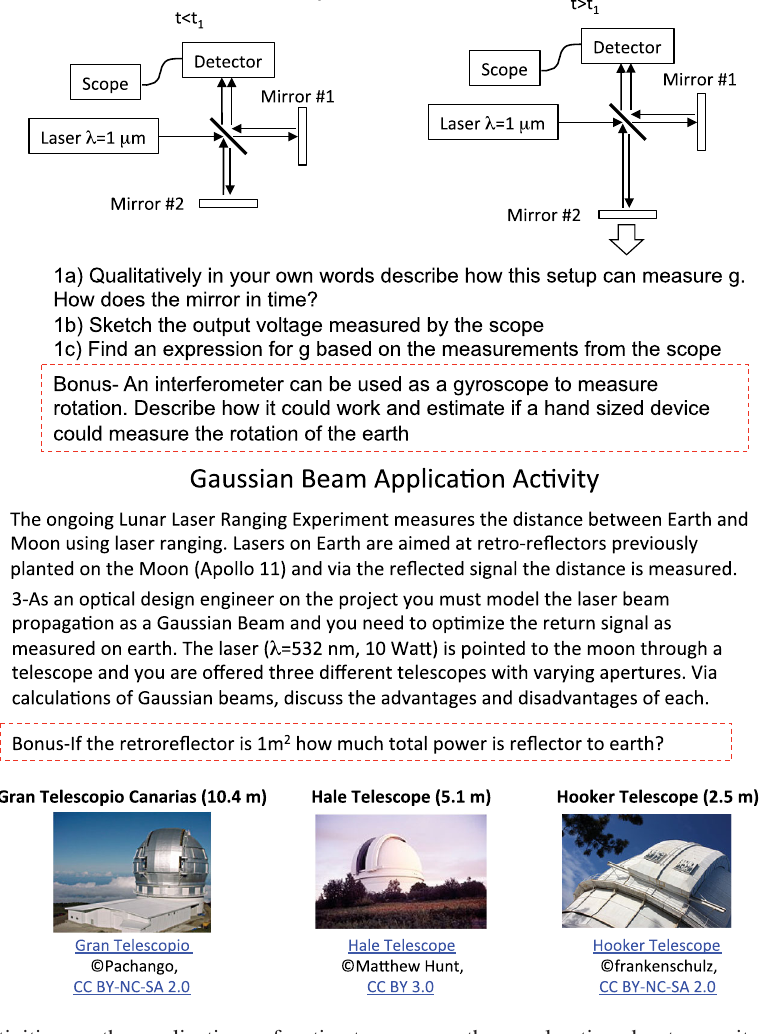
FIG. 5. In-class activities on the applications of optics to measure the acceleration due to gravity and for lunar